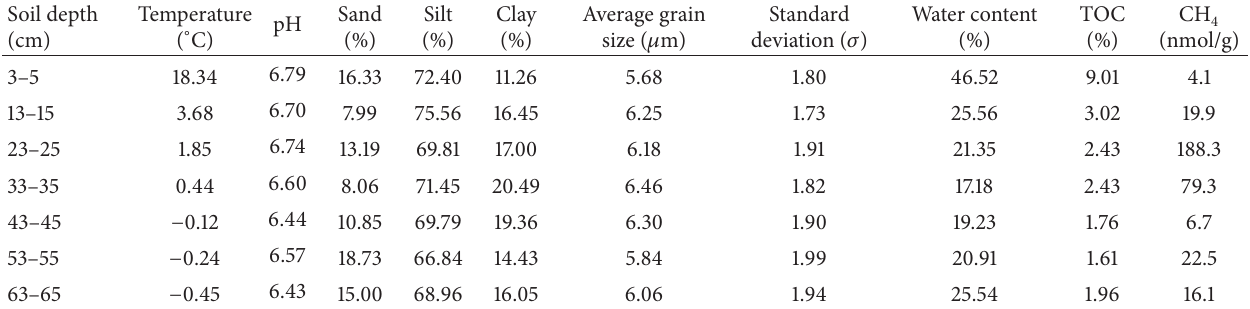
Table 1: Physiochemical properties of soil samples at different